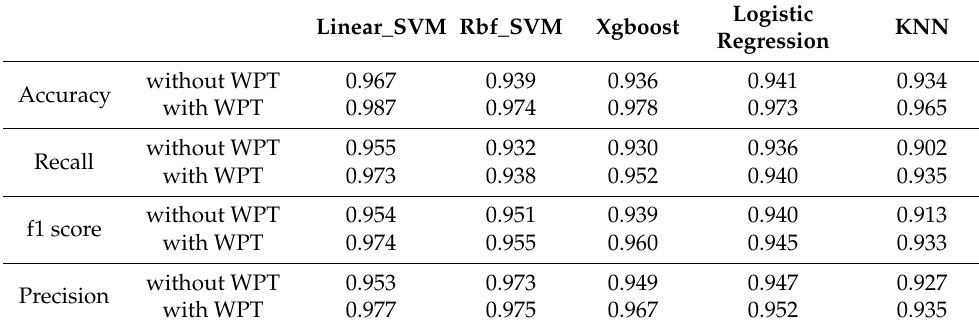
Table 4. Comparison of different methods: accuracy, recall, f1 score and precision on different classifiers with or without WPT.